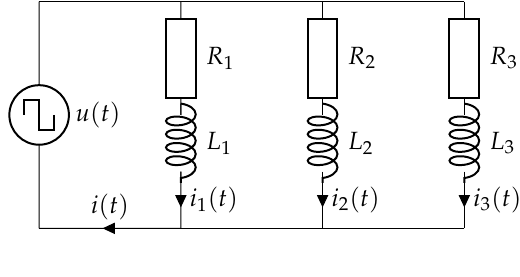
Figure 6. Simplified electromagnet